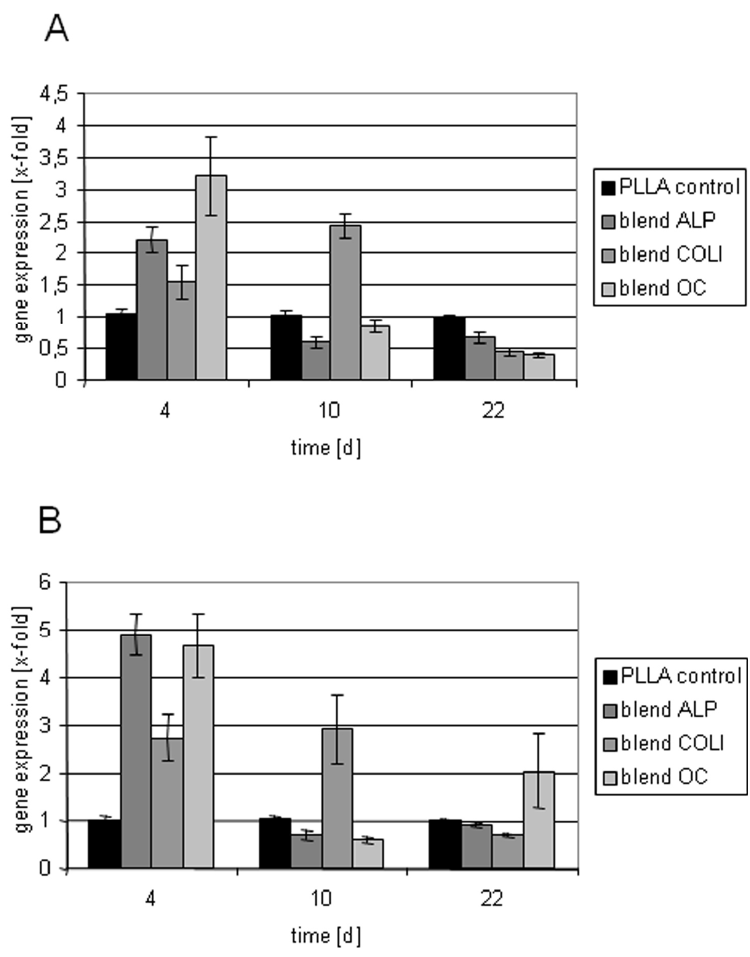
FIGURE 6. Influence of PLLA-COLI (4:1) blend on gene expression. Time course of gene expression of hMSC cultured under growth (A) and osteoinductive conditions (B),